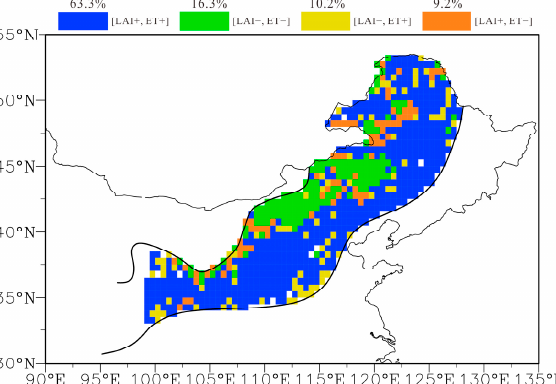
Figure 10. The trend patterns for ET and LAI in NDPB during 2001–2011. The plus sign (+) denotes an increasing trend and the minus sign ( − ) for a decreasing trend.